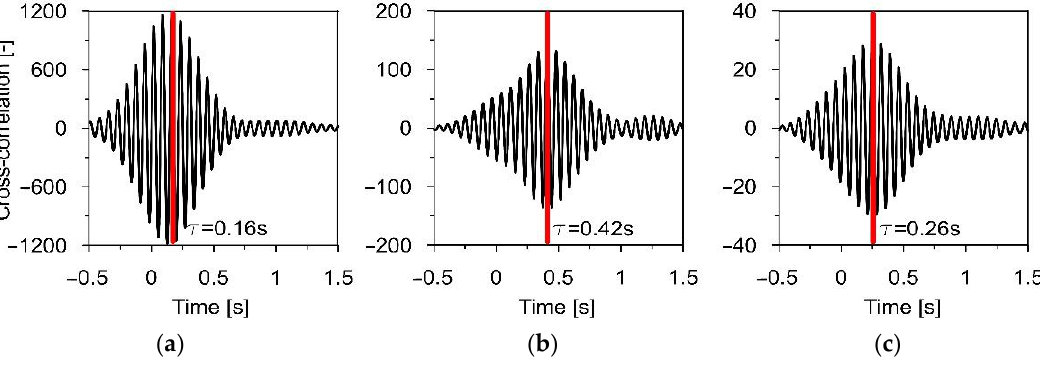
Figure 10. The cross-correlation functions for signal pair: ( a ) P1–P2, ( b ) P1–P3, ( c )